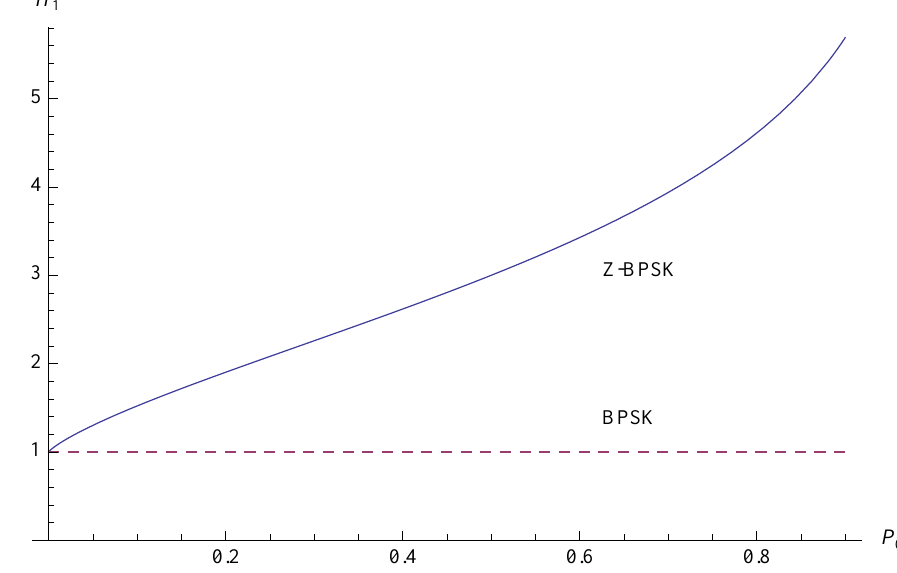
Figure 3. Entropy per unit of energy of the Z-BPSK (solid line) and classic BPSK (dashed line) as a function of the probability of emission of the zero